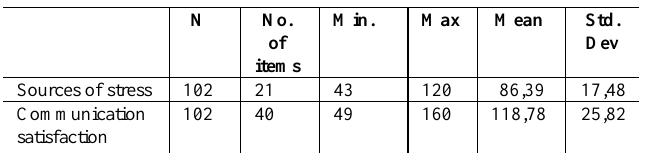
Table 1: Descriptive statistics for sources of stress